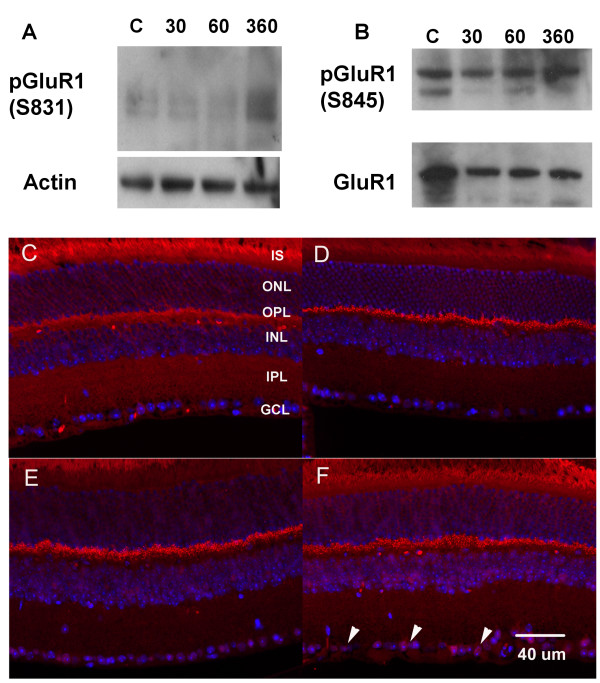
Phosphorylation of GluR1. A. Phosphorylation of GluR1 at Ser-831 increased at 6 hrs after optic nerve crush. B. GluR1 protein levels remained relatively constant, while phosphorylation of Ser-845 increased by 6 hrs. C-F. Immunohistochemistry of phosphorylated GluR1 (Ser-845) at 0, 0.5, 1, and 6 hrs after optic nerve crush. Increased pGluR1 is apparent in the ganglion cell layer (arrowheads) at 6 hrs after optic nerve injury. Red, = pGluR1, Blue = DAPI. IS, inner segment; ONL, outer nuclear layer; OPL, outer plexiform layer; INL, inner nuclear layer; IPL, inner plexiform layer; GCL, ganglion cell layer.